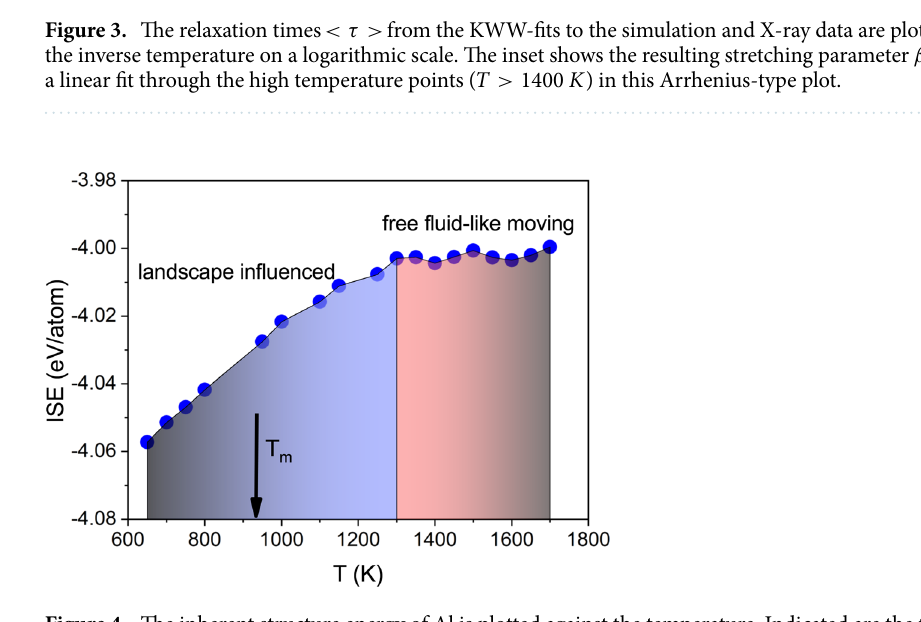
Figure 4. The inherent structure energy of Al is plotted against the temperature. Indicated are the two main regions of particle mobility according to the ISE within the energy landscape